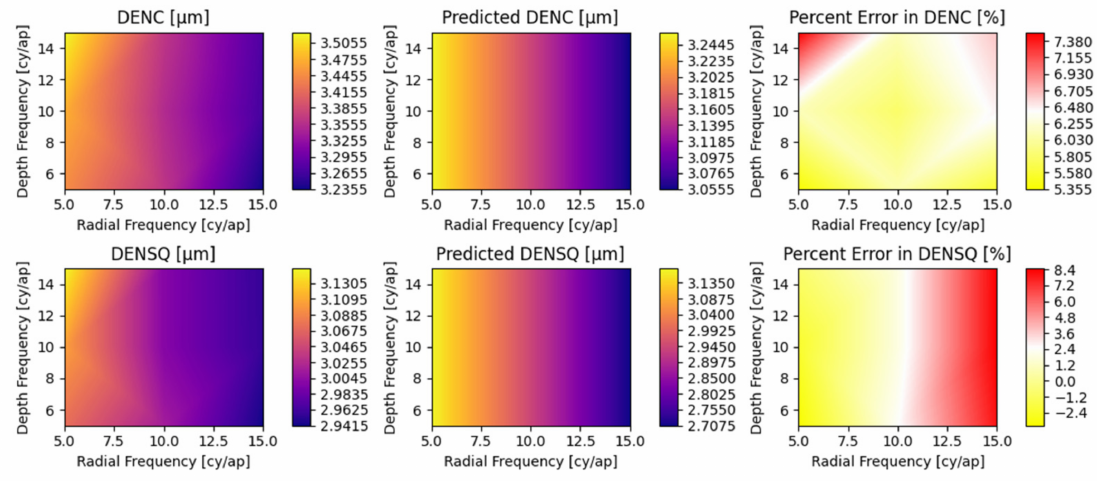
Figure A7. Radial Frequency versus depth frequency. (3 × 3 sampling matrix, κ = ω = δ = 0, η = 0.15, σ = 0.05, θ = 30 ◦